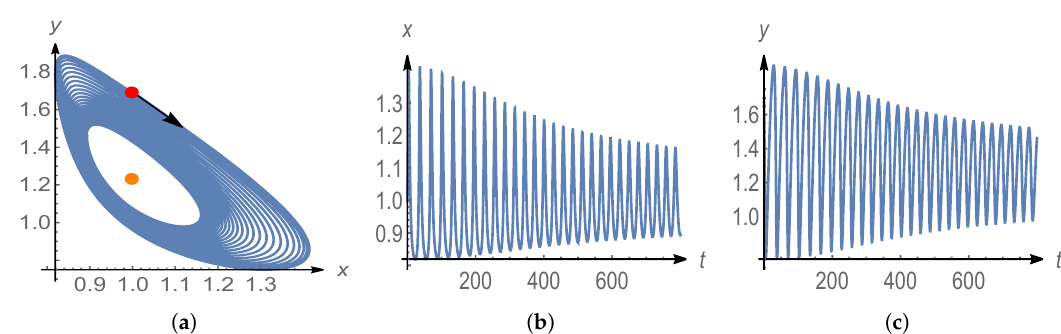
Figure 10. Model 2 with an unstable outer and a stable inner limit cycle. The trajectory is going inward, approaching the inner limit cycle as t → ∞ and the outer limit cycle as t → − ∞ ( d = 0.46).